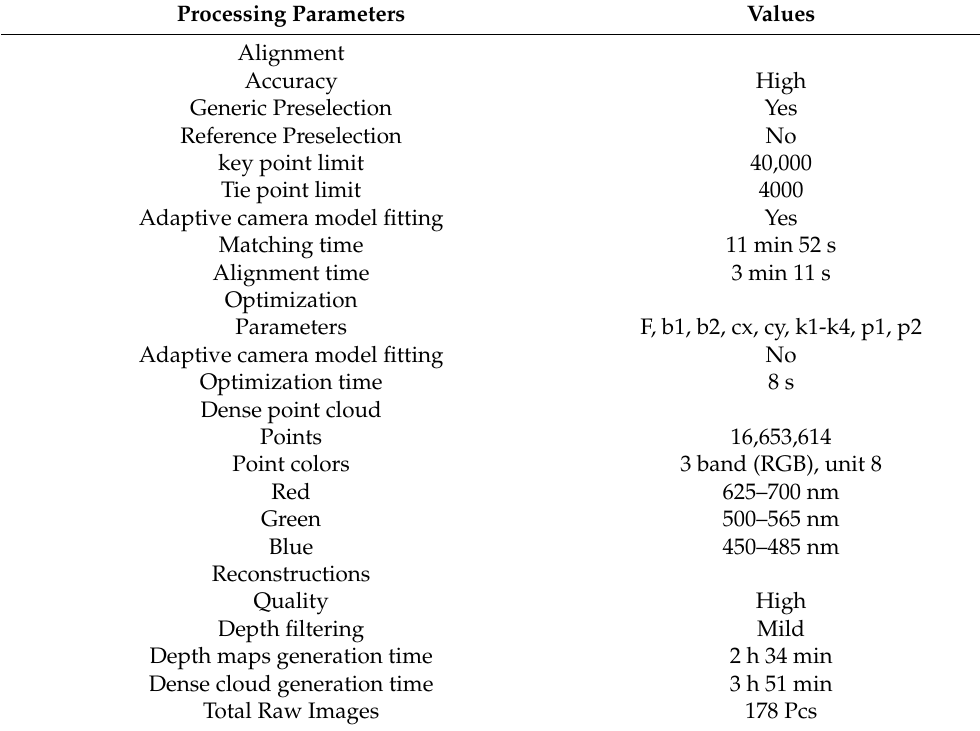
Table 2. Agisoft processing parameters.